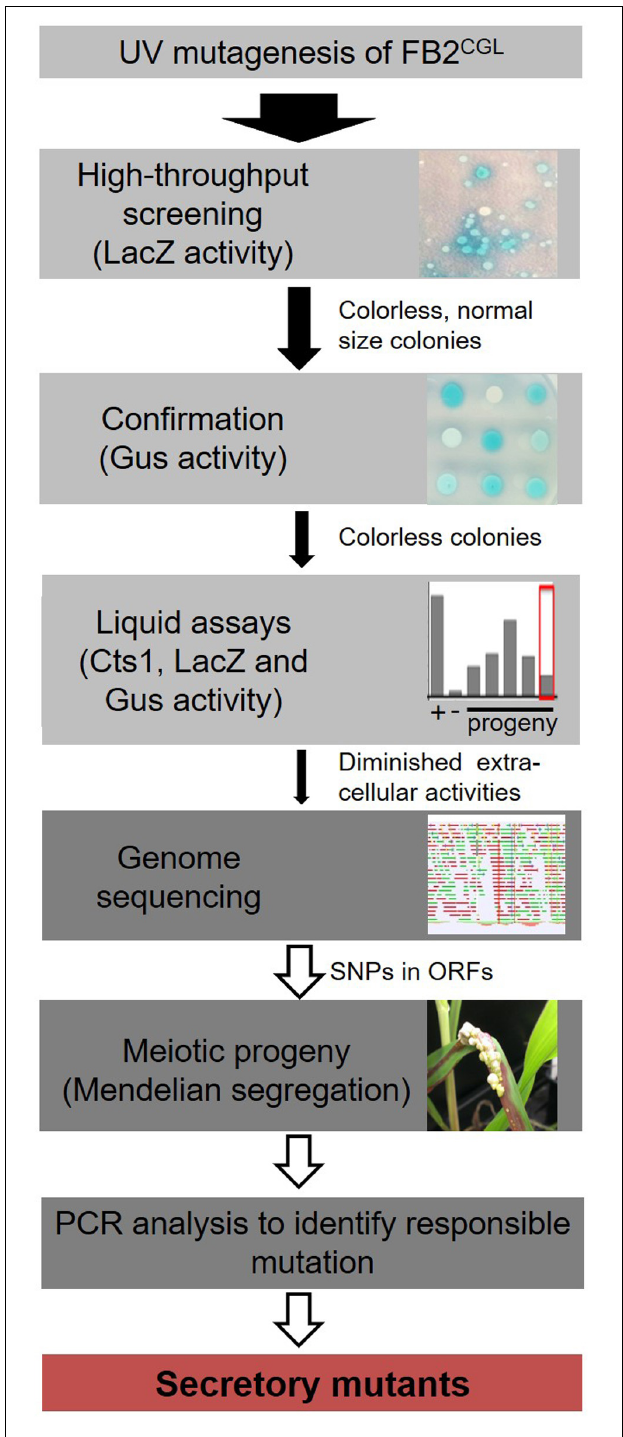
FIGURE 1 | Rationale of the forward genetic screen. The three reporters LacZ-Cts1, Gus-Cts1 and endogenous Cts1 were used to identify mutants with diminished Cts1 secretion. After UV mutagenesis, a high-throughput screen for absence of LacZ activity of LacZ-Cts1 was conducted on X-Gal containing plates. Next, colonies were patched on X-Gluc containing plates to verify the result with the Gus-Cts1 reporter. Remaining candidates